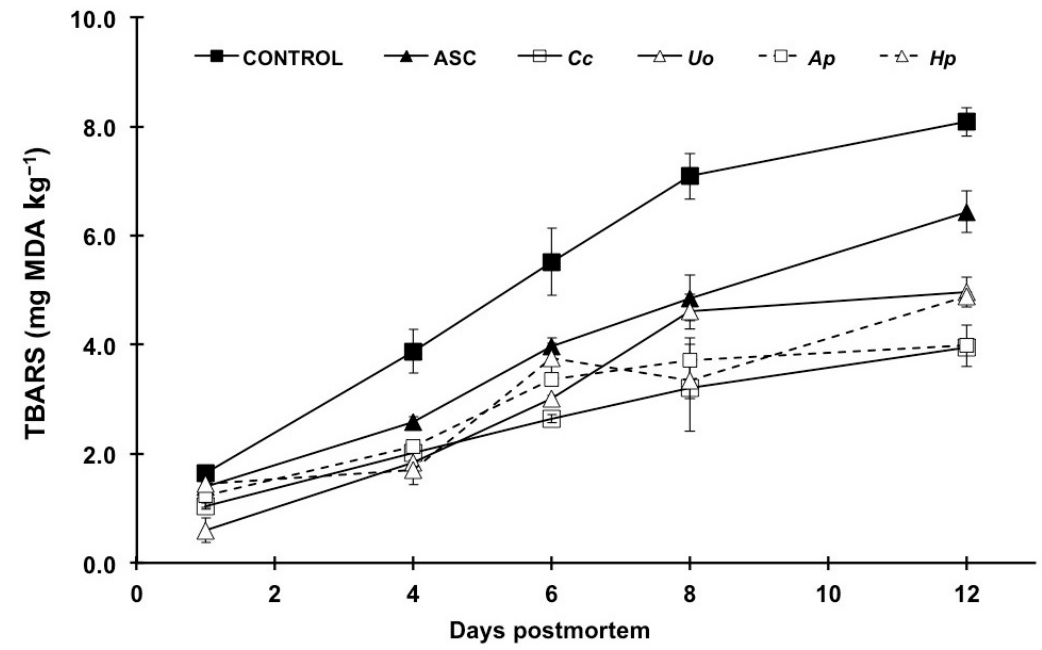
Figure 2. Time course of lipid oxidation in rainbow trout fillets treated with distilled water (CONTROL); ascorbic acid (ASC) and aqueous extracts of Crassiphycus corneus ( Cc ), Ulva ohnoi ( Uo ), Arthrospira platensis ( Ap ) and Haematococcus pluvialis ( Hp ) during a 12-day cold storage (4 °C) period. Values are given as mean ± sd. TBARS stands for thiobarbituric acid reactive substances, expressed as mg malonyldialdehyde (MDA) kg − 1 .